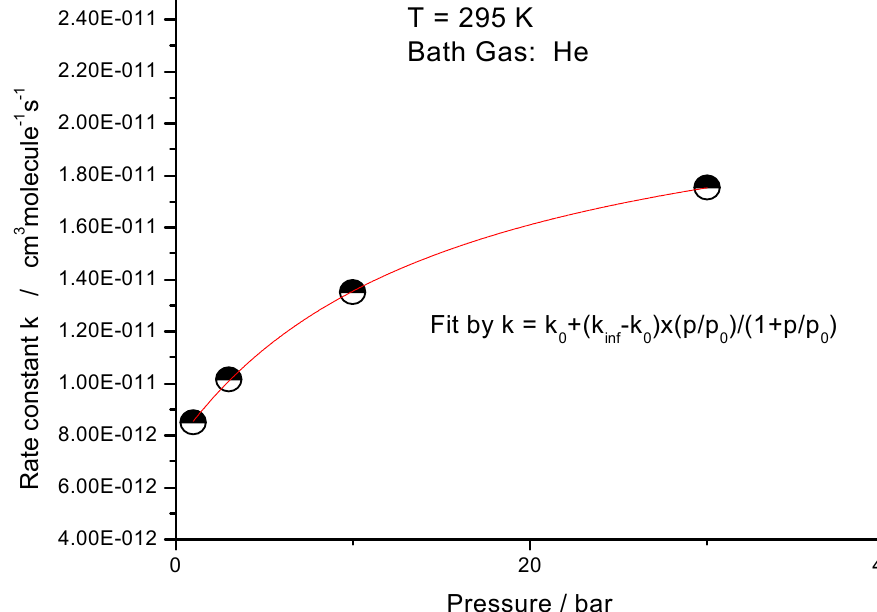
Figure 5. Pressure dependence of the rate constant of reaction (1). Bath gas—He. Temperature 295 K. Smooth curve—fit using a simple model (see text). Fitted parameters: k 0 = (7.64 ± 0.12) × 10 − 12 cm 3 molecule − 1 s − 1 , k inf = (2.25 ± 0.044) × 10 − 11 cm 3 molecule − 1 s − 1 , and p 0 = (15.2 ± 1.2) bar. The expression (10) corresponds to a simple model, where all relaxation processes are described by a single parameter, p 0 , the transition pressure. The results of the fit are: the low-pressure limit rate constant, k 0 = k MTST = (7.64 ± 0.12)10 −12 cm 3 molecule −1 s −1 , the high-pressure limit rate constant, k inf = k TST = (2.25 ± 0.05)10 −11 cm 3 molecule −1 s −1 , and the transition pressure p 0 = (15.2 ± 1.2) bar. The study is planned to be extended to a wider pressure range (0–100 bar) as well to lower temperatures (down to ca. −80 °C).